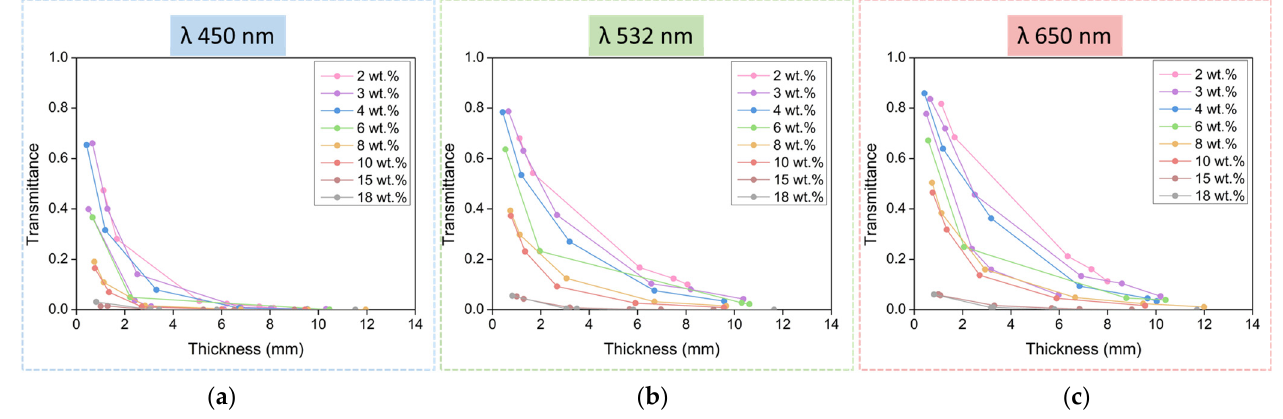
Figure 3. Transmittance dependence with sample thickness for materials produced with different catalyst contents at different wavelengths: 450 nm ( a ), 532 nm ( b ), and 650 nm ( c ).